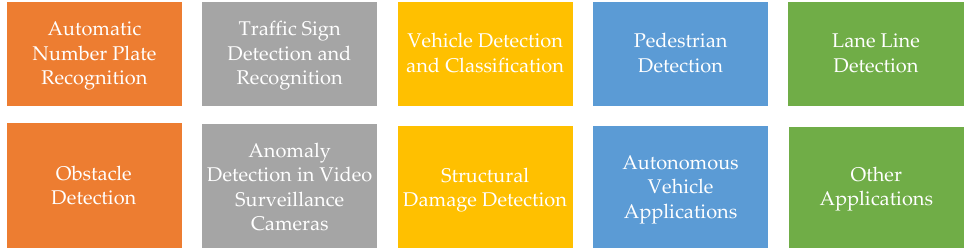
Figure 1. Computer Vision Applications in Intelligent Transportation Systems.